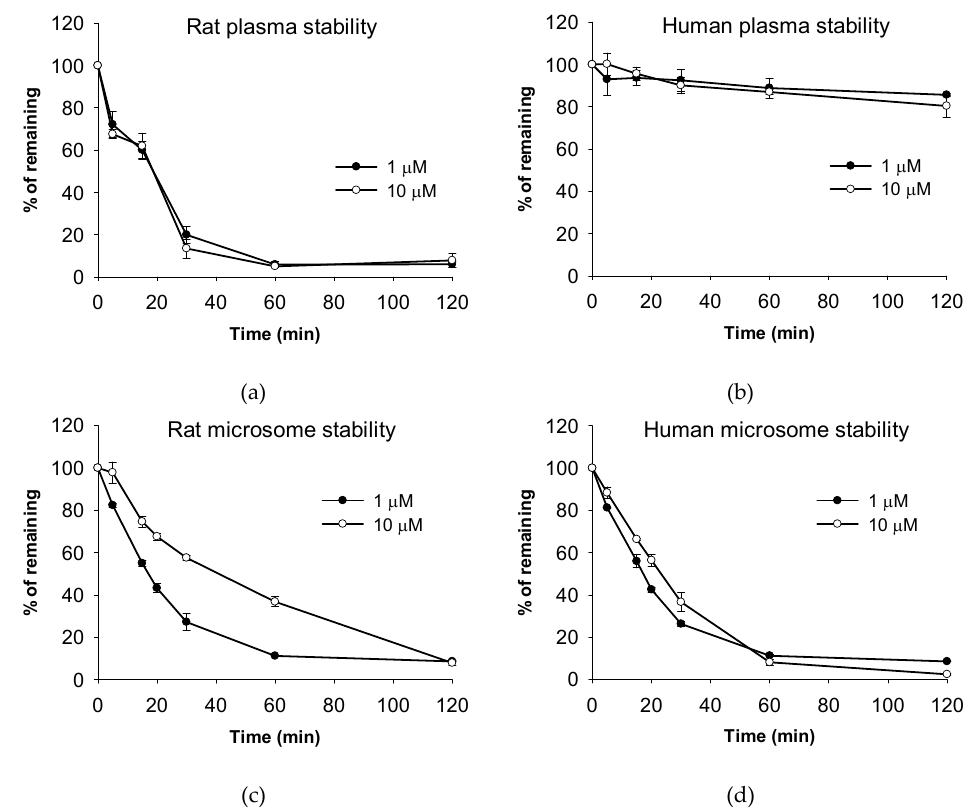
Figure 4 . Metabolic stability of ATBC in plasma and liver microsomal fractions. ( a ) Rat plasma; ( b ) human plasma; ( c ) rat liver microsomes; ( d ) human liver microsomes. Data were expressed as mean ± SD ( n = 3).